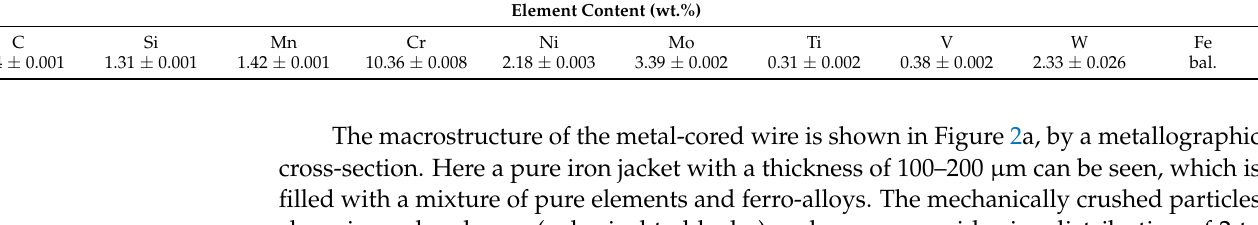
Table 3. Actual chemical composition of tool steel X36 metal-cored wire. Element Content